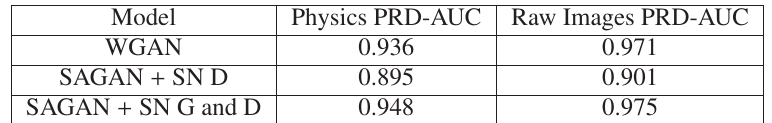
Table 1: PRD-AUC on test dataset